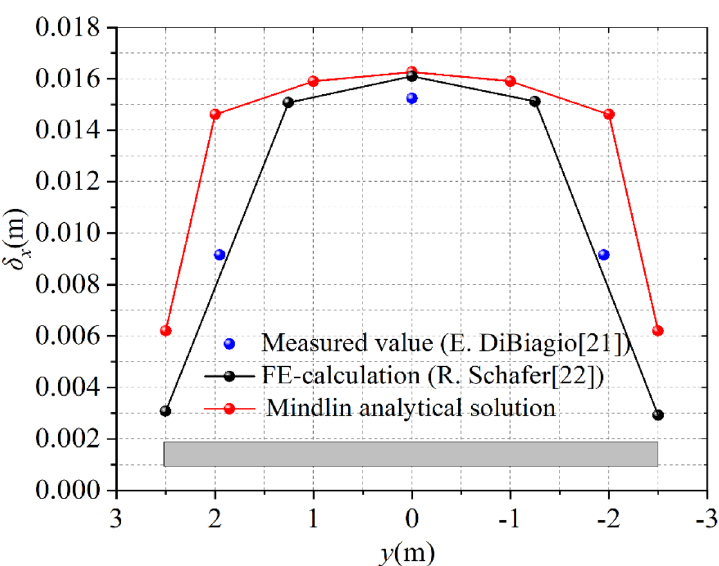
Figure 4. Horizontal displacement comparison results (at a depth of 15.5